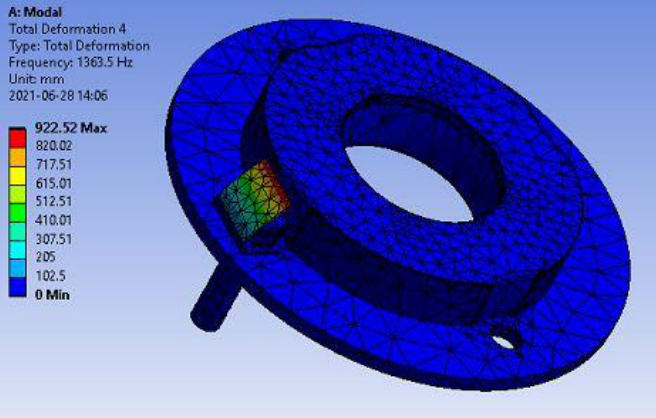
Figure 6. Mode shape of the bracket in the system modal analysis.